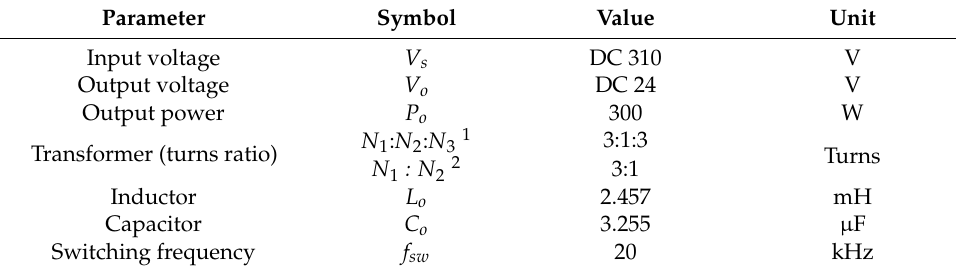
Table 2. Design parameters for forward